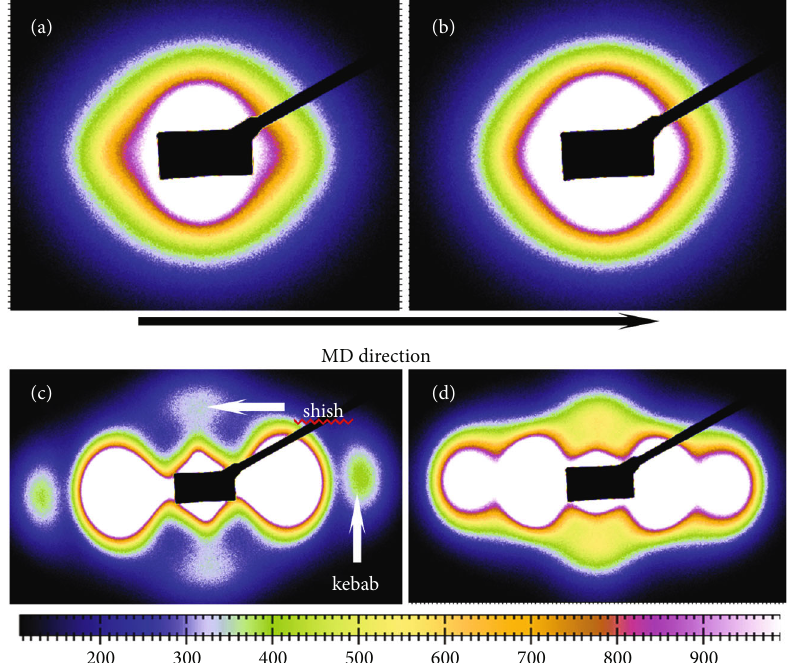
Figure 5: Small-angle X-ray scattering patterns of the PP fi lms: (a) initial BOPP fi lm, (b) BOPP fi lm after annealed at 130 ° C, (c) initial UOPP fi lm, and (d) UOPP fi lm after annealed at 130 °